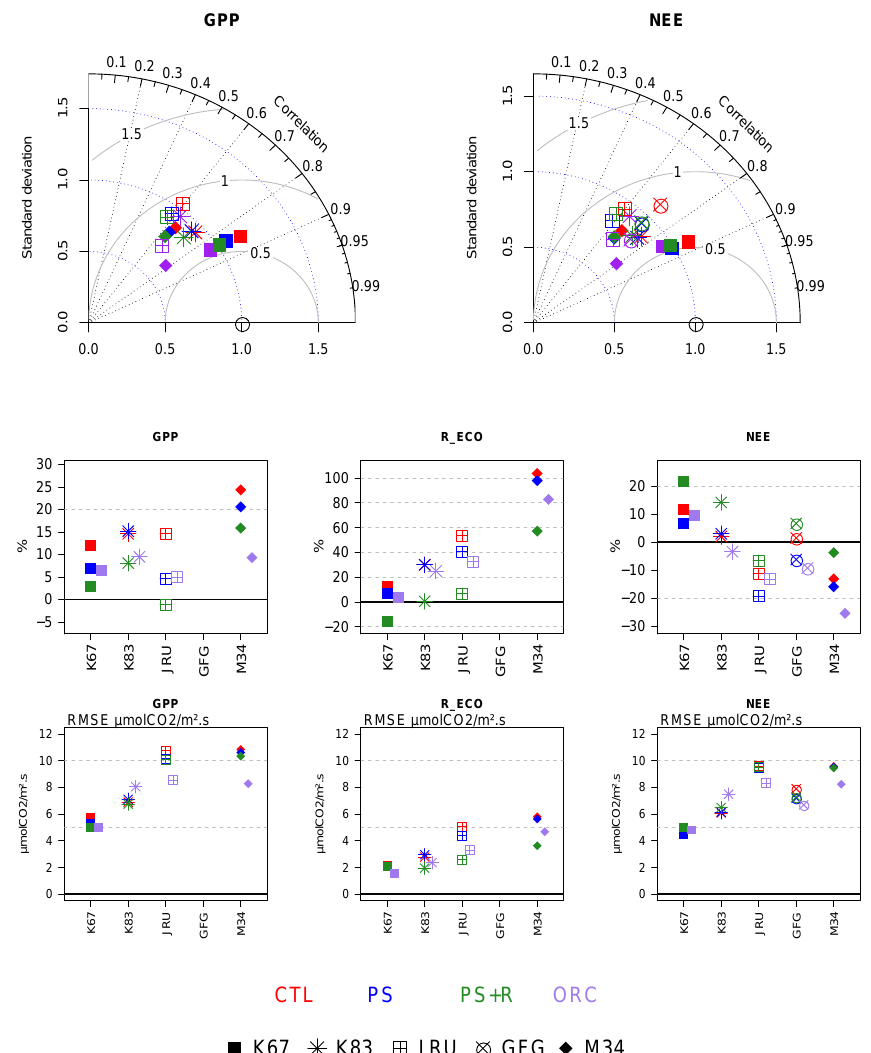
Figure 7. Taylor diagrams (top) for GPP and NEE and bias for GPP R ECO and NEE (%) (bottom) calculated among hourly values removing night values (short-wave down ≤ 5Wm − 2 ) at the five flux towers and for each available period (see Table 1). Note that at GFG only NEE time series was available. In the Taylor diagrams, correlation extends radially from the origin. The blue lines indicate identical ratios of standard deviation of the simulated flux to the observed flux. The gray lines represent identical root mean square errors (RMSE) of the centered